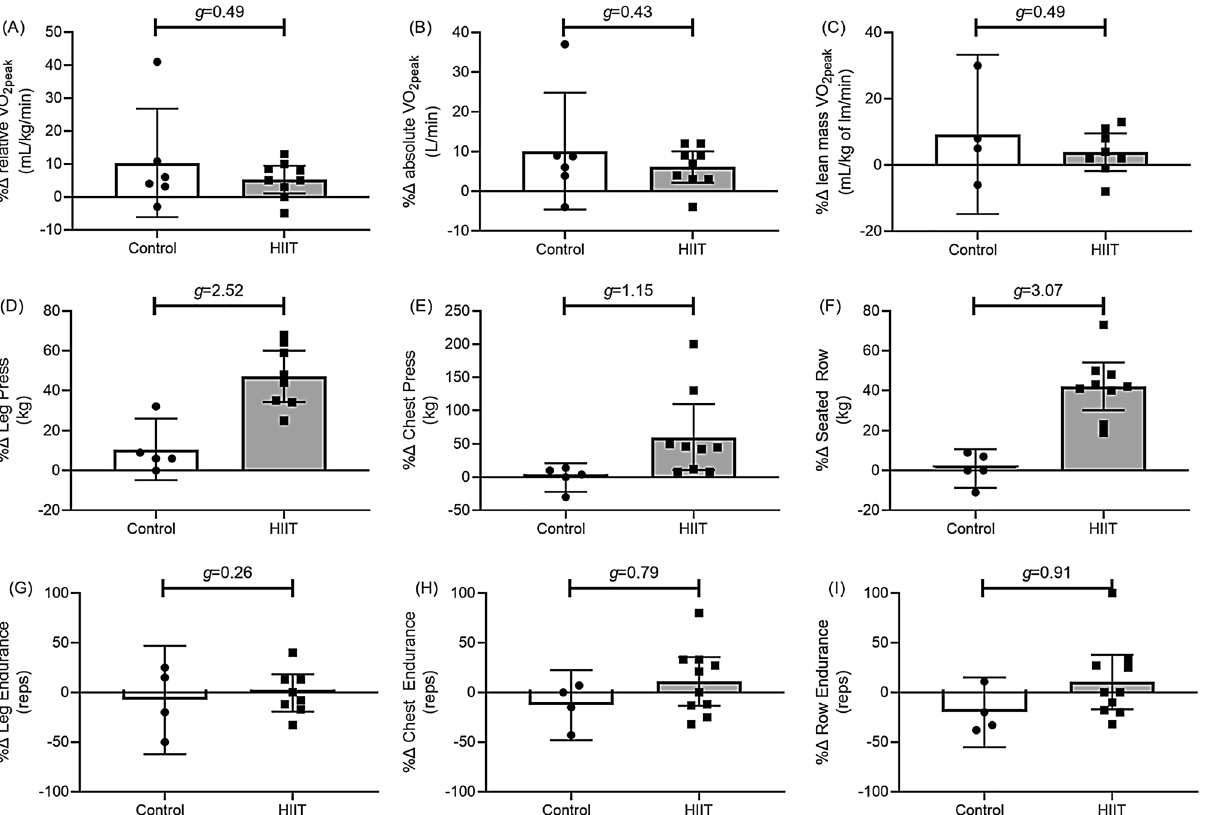
Figure 2. Mean (95% C.I.) percentage change (%∆) with Hedges G ( g ) group differences between HIIT and controls for cardiorespiratory fitness ( A – C ), estimated 1 repetition maximum strength ( D – F ), and number of repetitions completed at 70% of 1 RM ( G – I